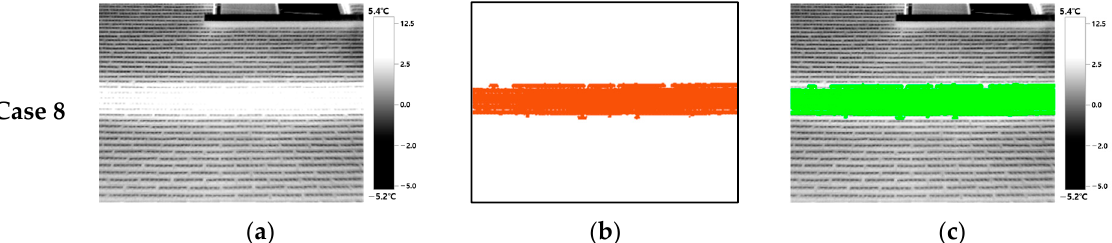
Figure 7. Experimental results: ( a ) thermal image, ( b ) clustering results, and ( c ) thermal bridge detection results.